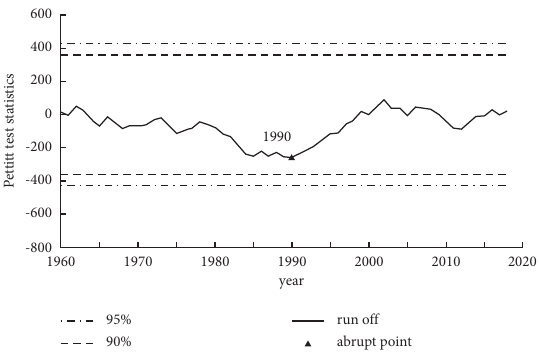
Figure 5: Abrupt change in annual runoff in the Yue River watershed during 1960–2018. Table 1: Hydrometeorological characteristic values in the Yue River